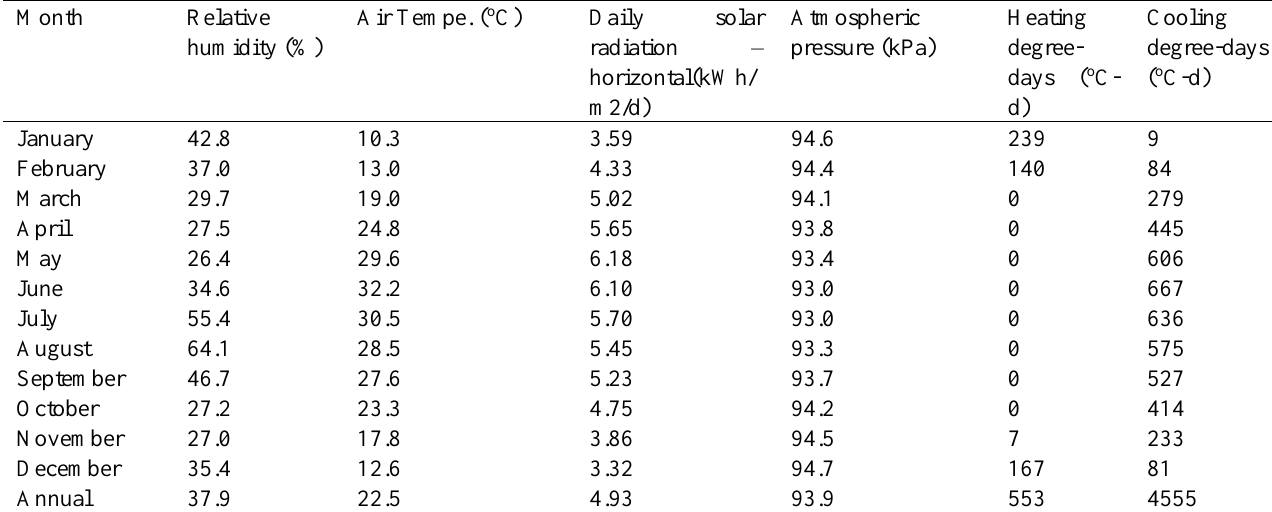
Annual solar irradiance data of the